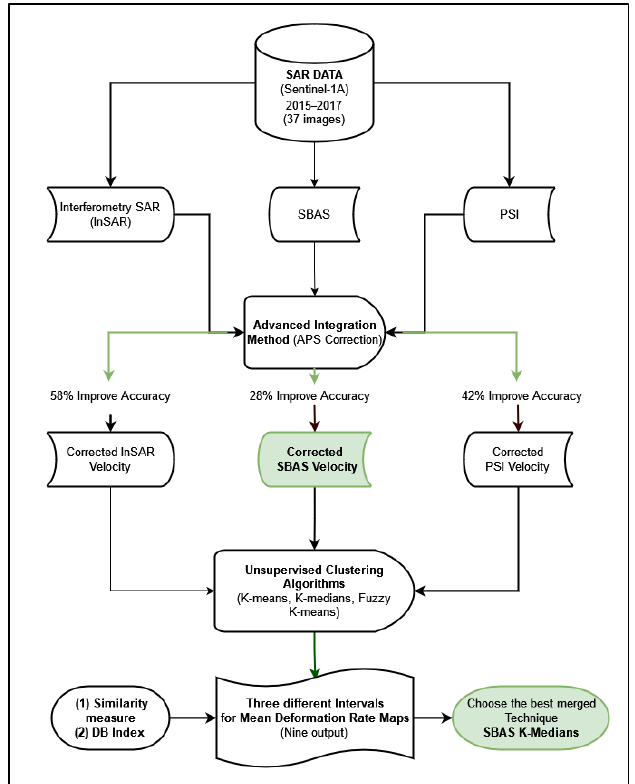
Figure 4. Flowchart. Figure 4.